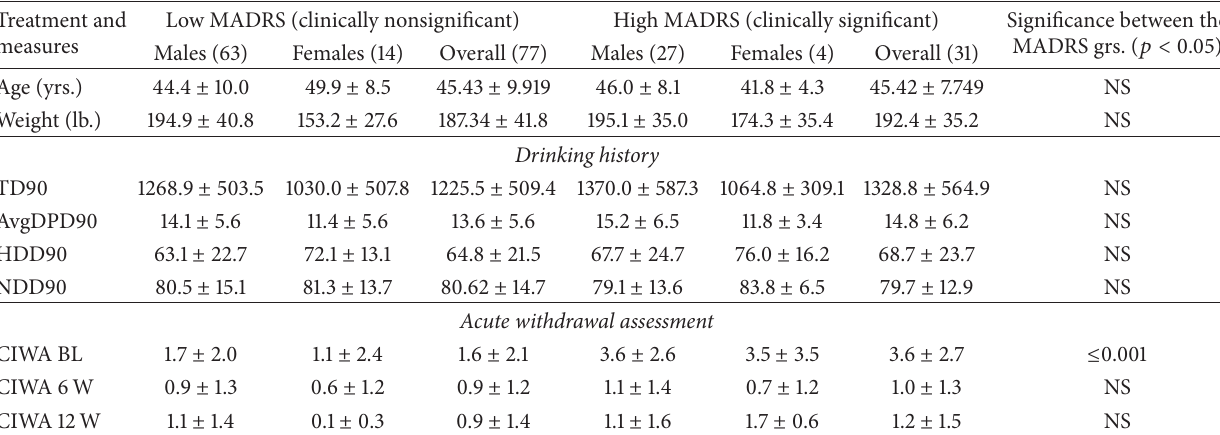
Table 1: Baseline demographics, drinking history markers, and acute withdrawal assessment in alcohol dependent patients by MADRS group and